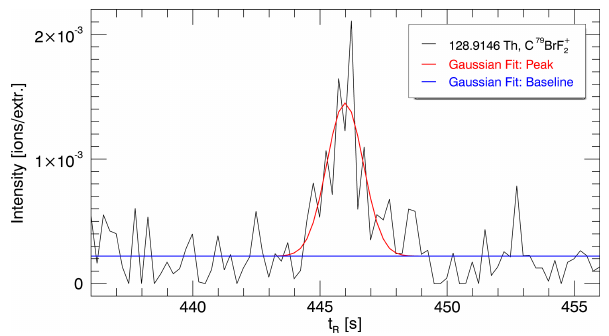
Figure 4. Chromatographic signal of Halon-1202 (CF 2 Br 2 ) on mass 128.9146Th (C 79 BrF + fragment) at a retention time ( t R ) 2 of 446s. Sample: H-218 flask AGAGE calibration gas, 490mL preconcentration